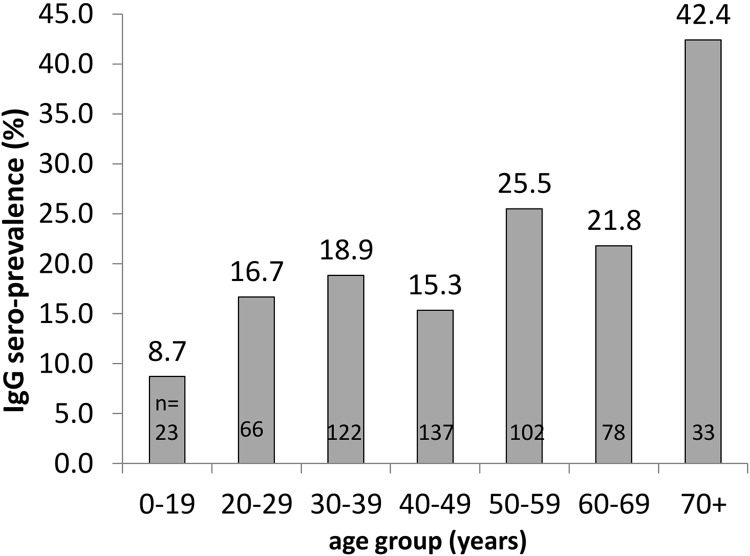
IgG sero-prevalence by age among controls.